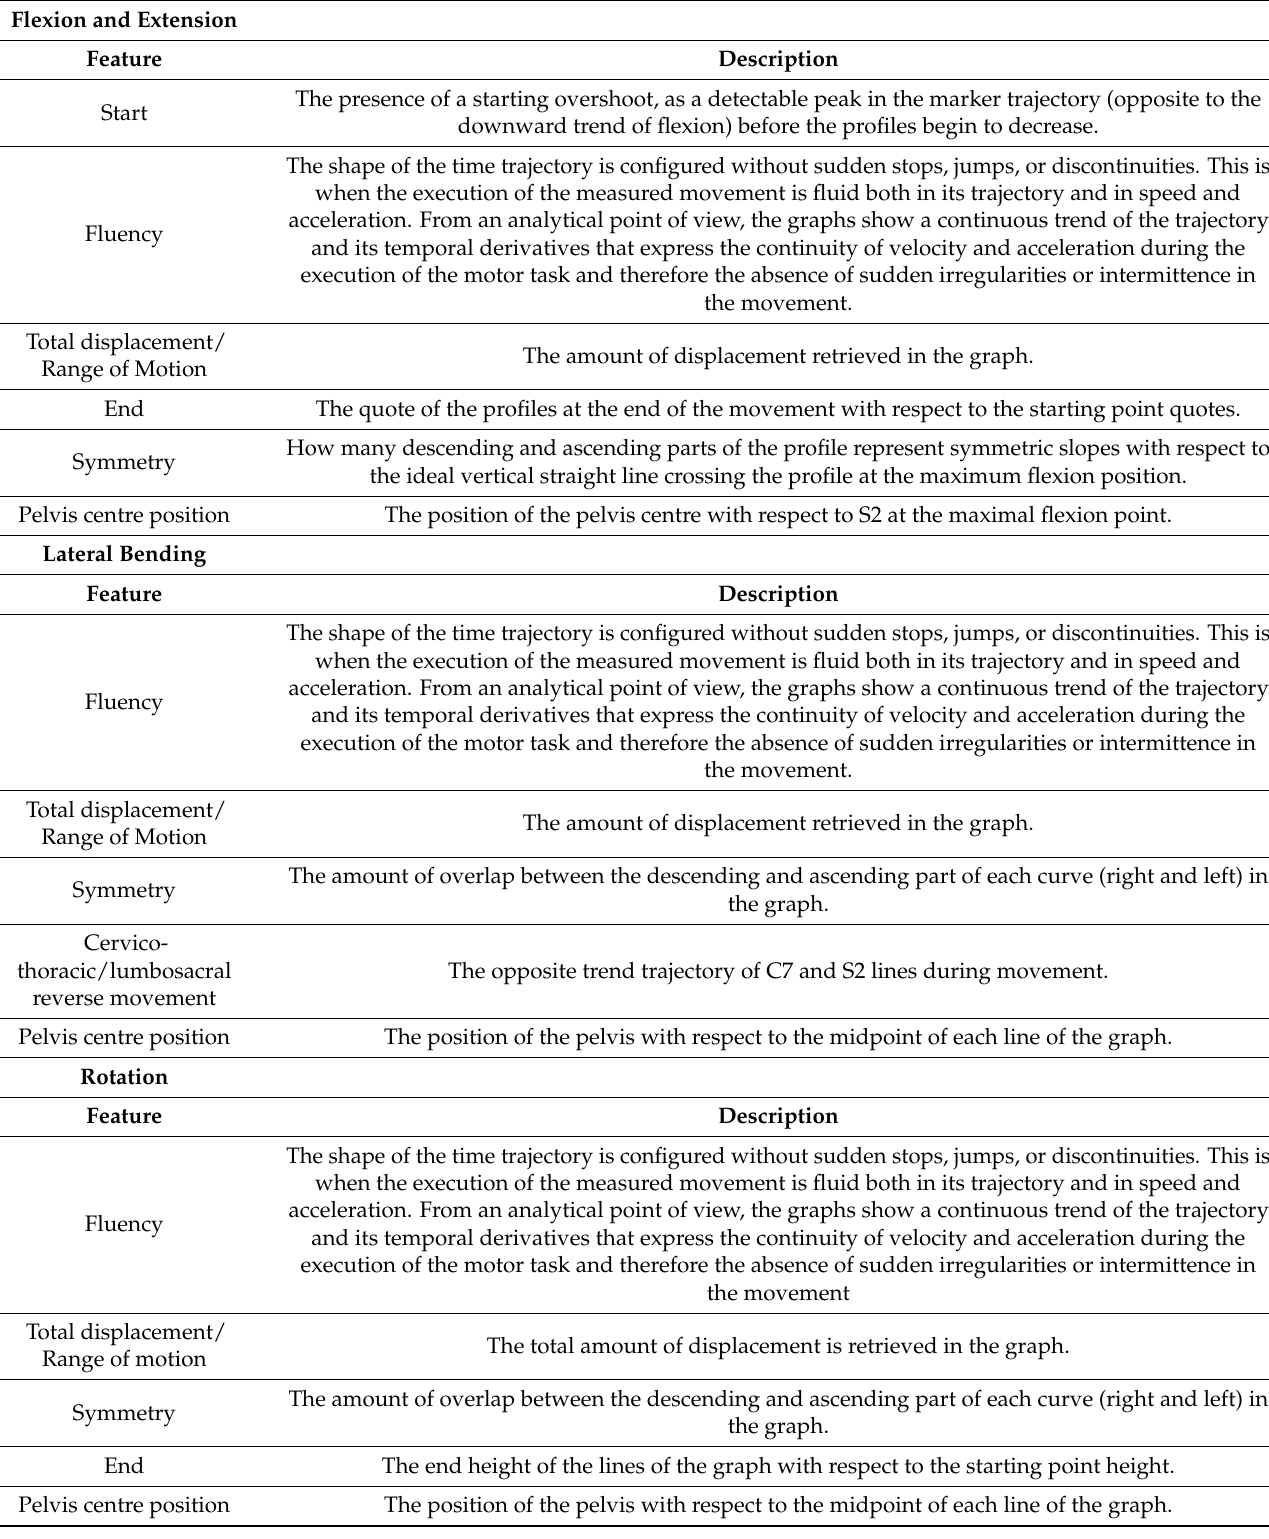
Table 1. Movement features identified through the observation of 55 healthy participants (the scoring criteria for each feature is detailed in Appendix